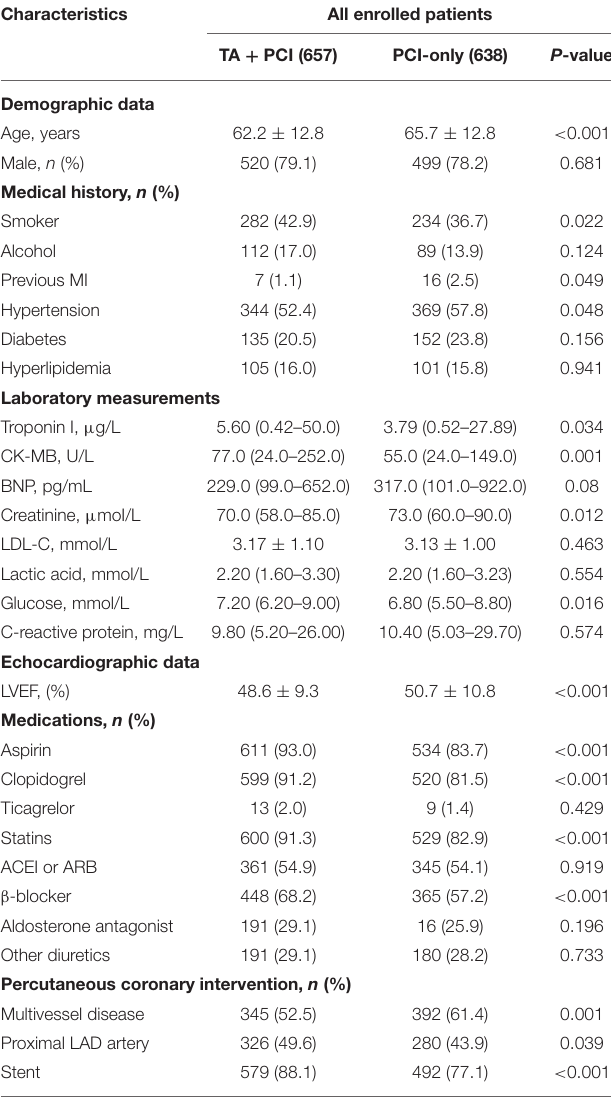
TABLE 1 | Baseline clinical and angiographic characteristics of all enrolled